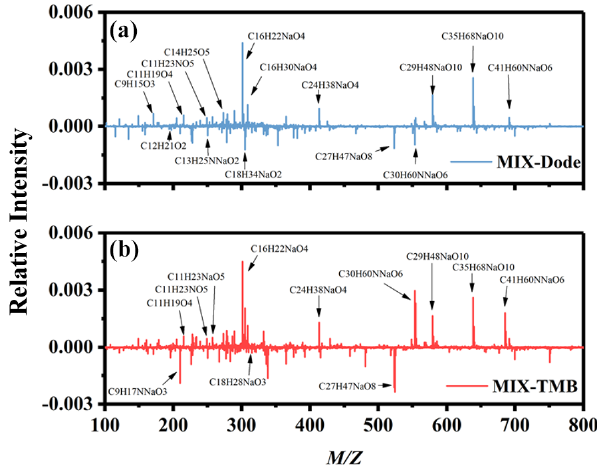
Figure 4. Results of mass spectra difference in (a) mixed AVOC SOA minus n -dodecane SOA and (b) mixed AVOC SOA minus 1,3,5-TMB SOA. The y axis is the relative intensity normalized by dividing by the total signal strength of the mass